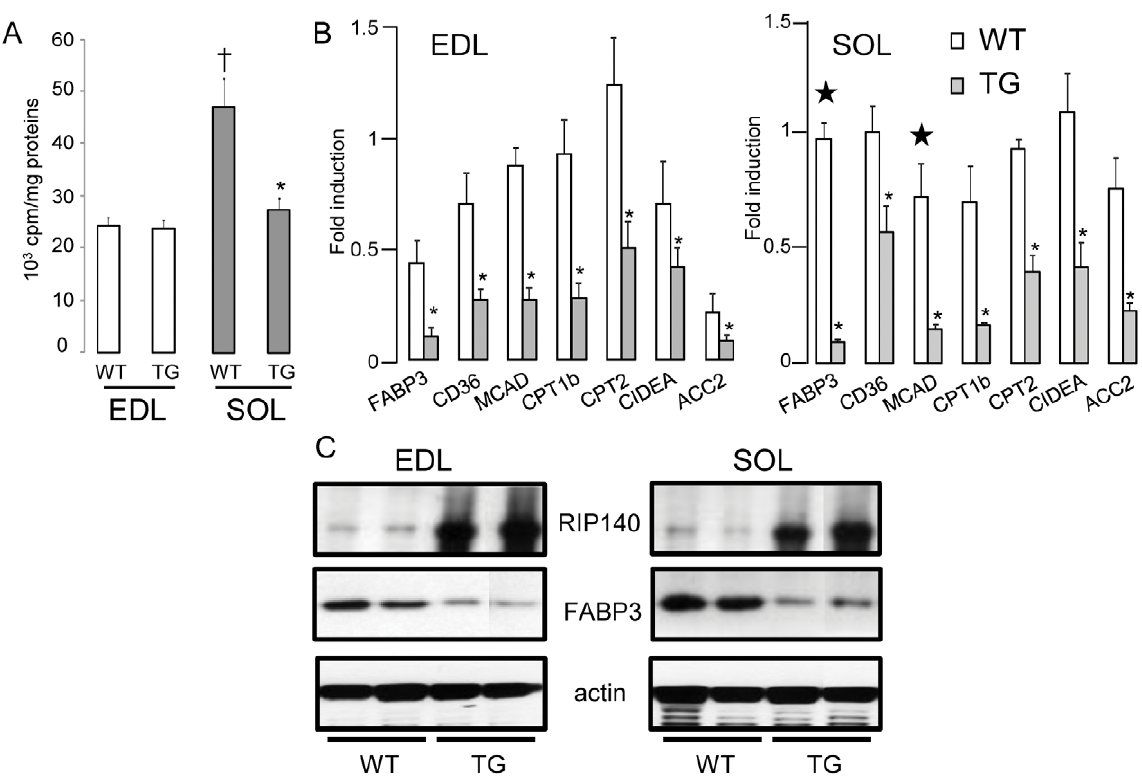
Figure 3. Exogenous expression of RIP140 inhibits fatty acid utilization in the soleus. (A) b -oxidation rate, normalized to proteins, monitored in EDL (n=8) and soleus (SOL) (n=4) isolated from RIP140 transgenic (TG) and WT mice. Data are expressed as mean 6 SEM. *p , 0.05, WT vs KO; { p , 0.05, WT soleus vs WT EDL. (B) Real-time RT-PCR analysis of genes implicated in fatty acid binding and transport in EDL and soleus (SOL) of RIP140 transgenic (TG) and WT mice. Data are comparable between histograms for the same gene and expressed as mean 6 SEM. *p , 0.05, WT vs TG. ???Data were published already in [25]. (C) Analysis of RIP140, FABP3 and actin expression in RIP140 transgenic (TG) and WT EDL and soleus (SOL) by western